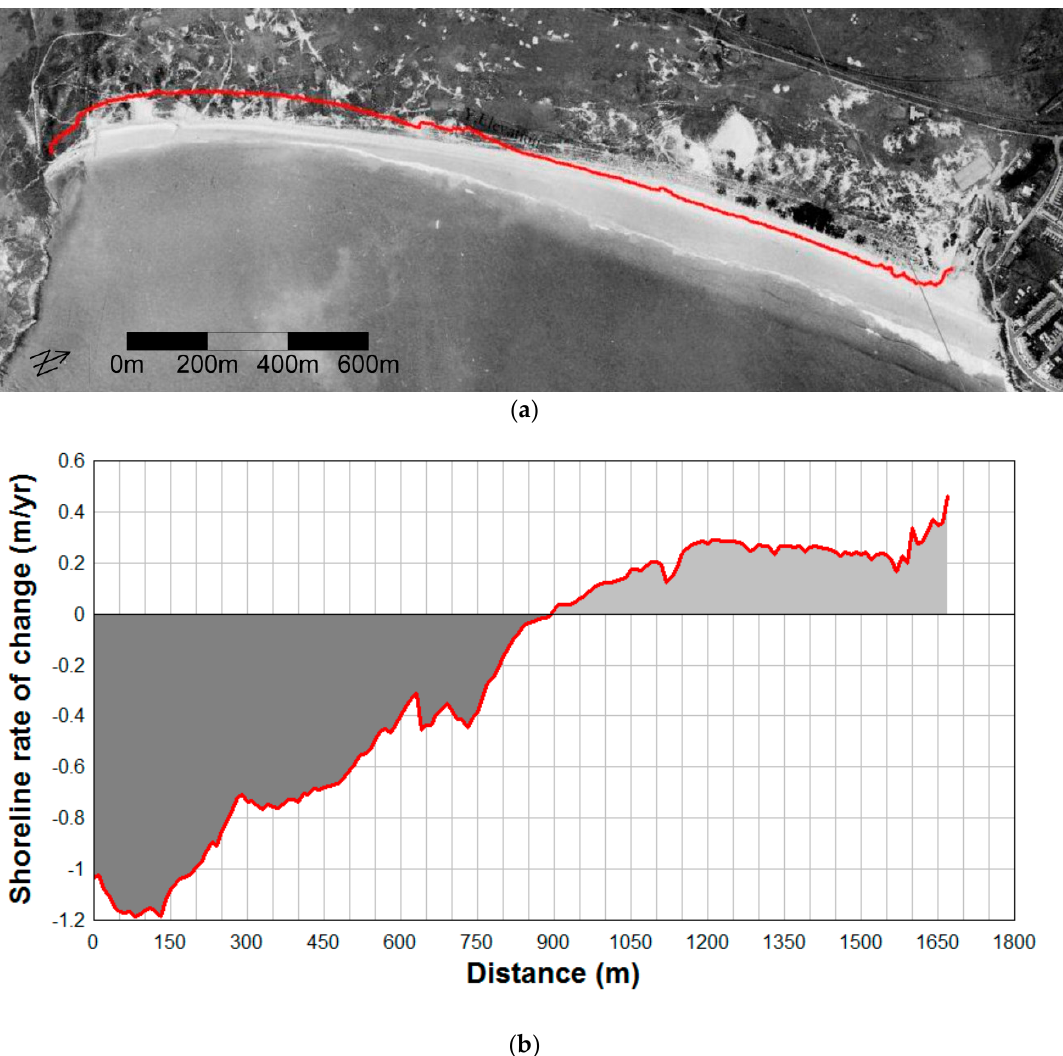
Figure 7. ( a ) Shoreline position of 2014 (red line) superimposed upon the 1941 aerial photograph and ( b ) a graphical representation of shoreline change between 1941 and 2014. Note:—light grey = accretion and dark grey = erosion.